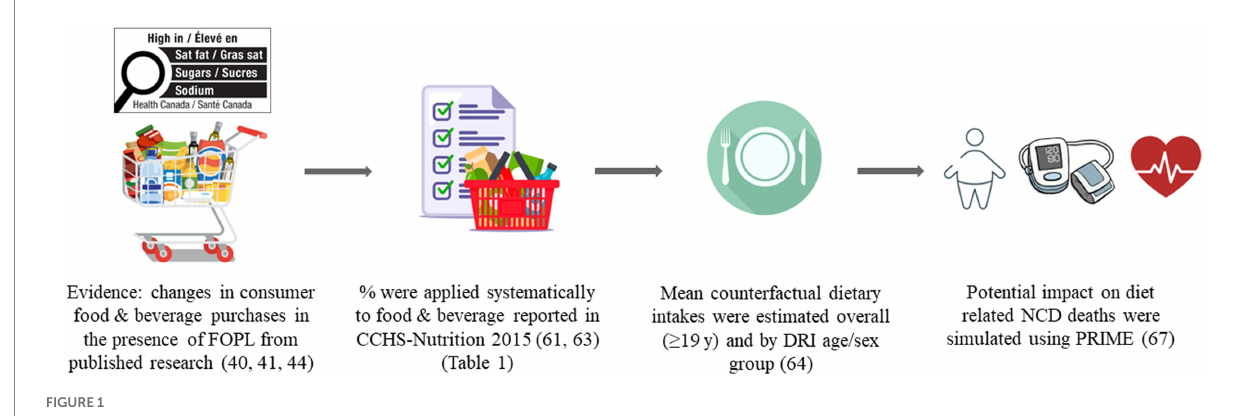
FIGURE 1 Overview of the steps followed in the simulation modeling study. Full details of each counterfactual scenario and sensitivity analysis are described in the methods section.